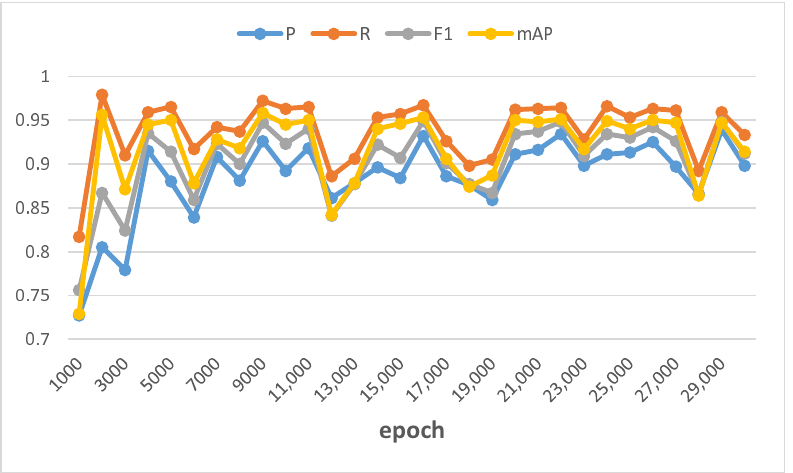
Figure 6. Detection results under